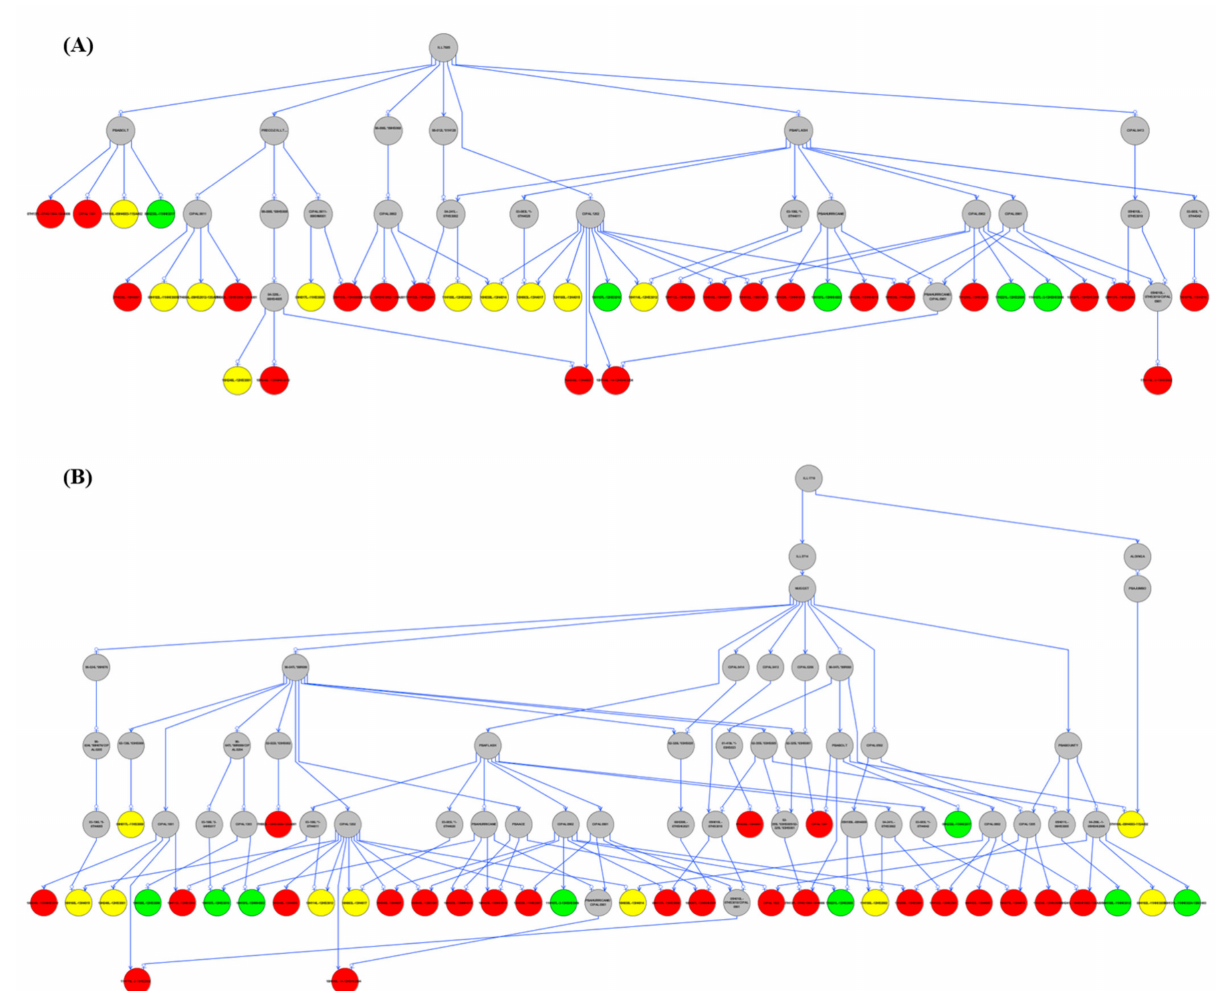
Figure 4. Pedigree analysis on tolerant lentil accessions ( A ) ILL7685 as the parental source ( B ) ILL1719 as the parental source. Salt tolerant accessions were color-coded according to the haplotypes identified in the current study; Red: Hap1, Green: Hap2, and Yellow: Hap1/2.